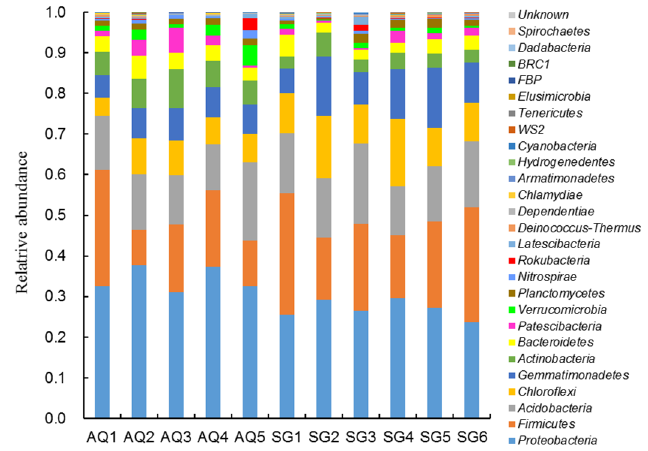
Figure 1. The profile of bacterial communities in different greenhouse soils (phylum level).